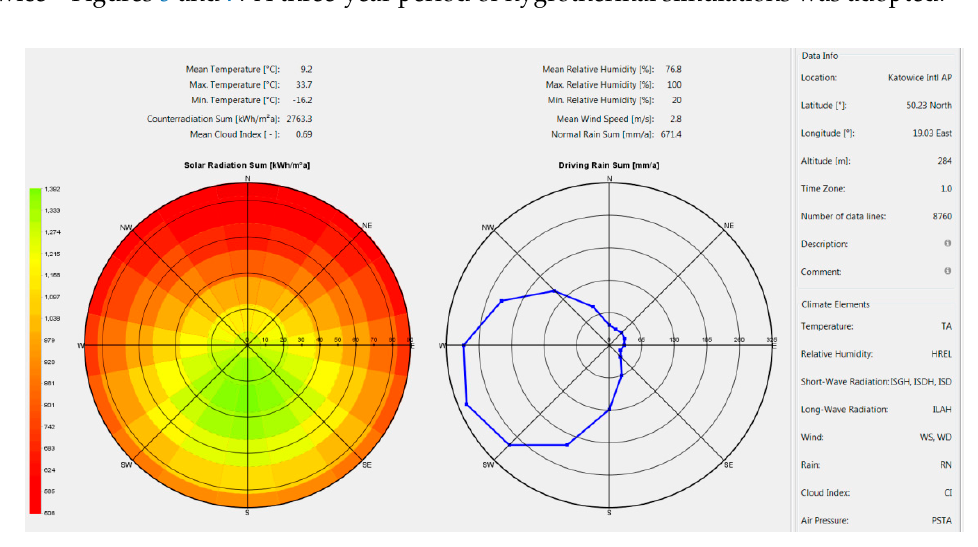
Figure 7. External climate parameters adopted for analysis.